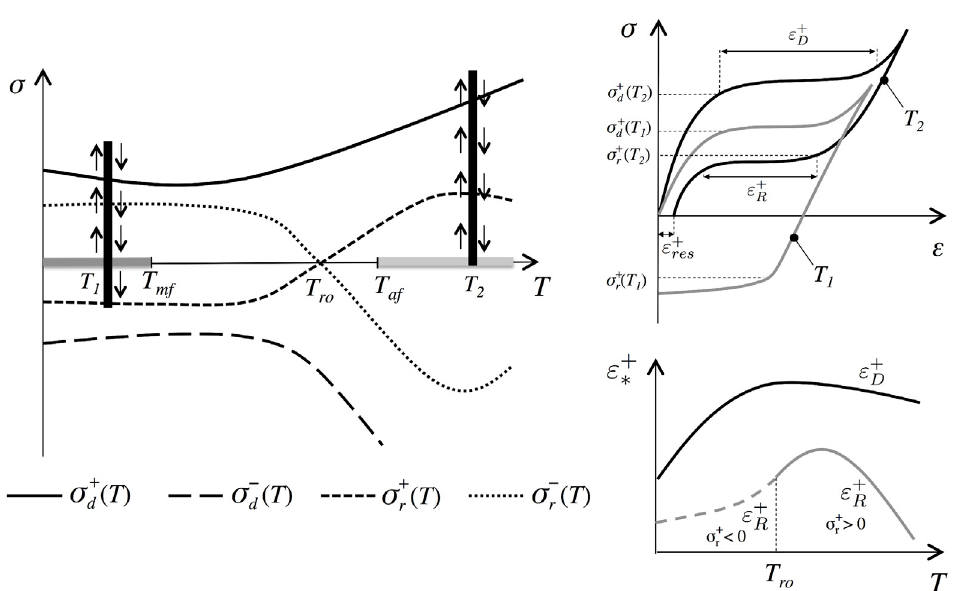
  ) and to Ms- (   ), d d = T T and 1